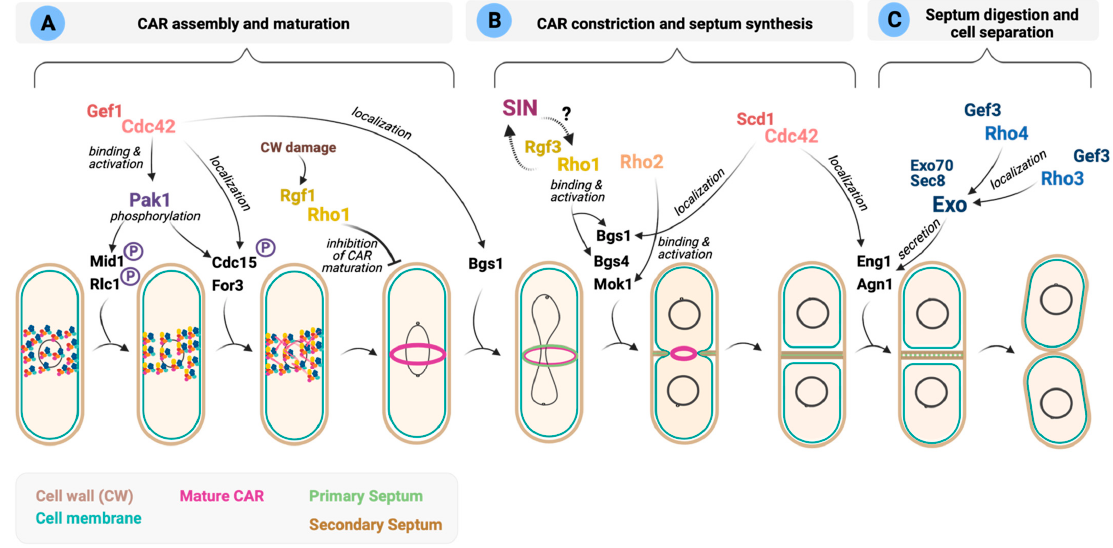
Figure 4. Rho signaling during cytokinesis. Schematic representation of fission yeast cytokinesis. ( A ) CAR precursors are assembled into nodes (